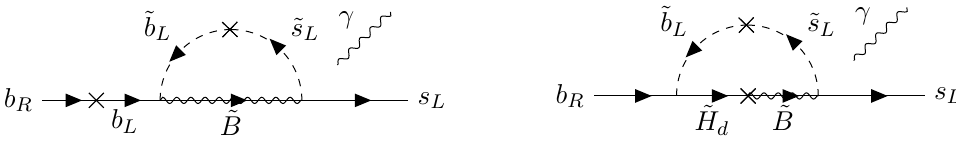
s(cid:13) mediated by a light bino, with external !